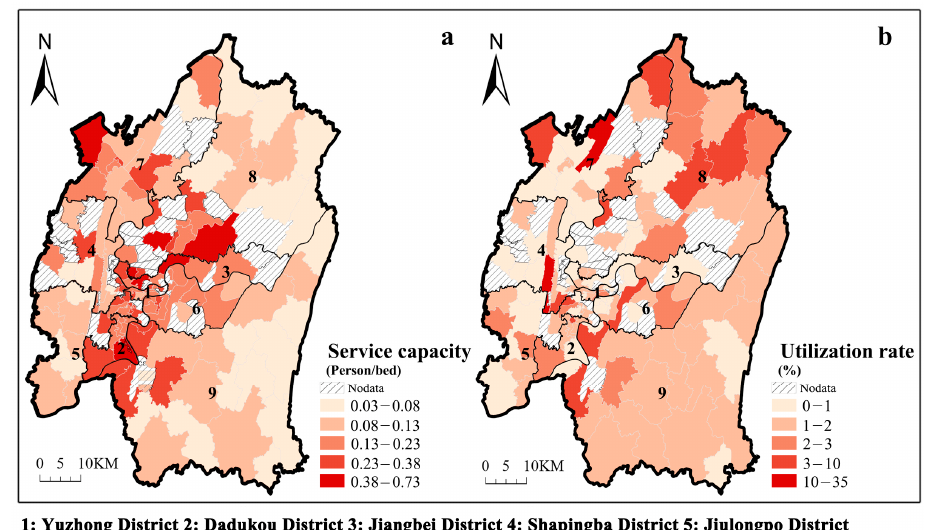
Figure 7. Spatial distribution of service capacity ( a ) and space utilization ( b ).